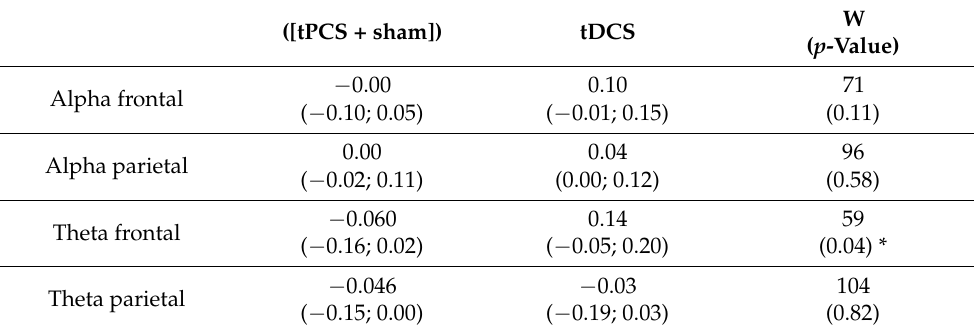
Figure 4. Group differences between treatment conditions on ([tPCS + sham]) and tDCS: ( a ) on theta frontal functional connectivity, ( b ) on CRS-R total score, and ( c ) on CRS-R modified index. Calculated with unpaired Wilcoxon signed-rank test. tPCS = transcranial pulsed current stimulation, sham = sham, tDCS = transcranial direct current stimulation. Table 3. Detailed results from the exploratory analysis testing [tPCS + sham] against tDCS condition. Cells report the median and (IQR25—IQR75) of each band and region for each condition. For example, the alpha frontal median for the [tPCS + sham] condition was − 0.002 and IQR25 − 0.107, IQR75 0.051. The last column reports the Wilcoxon index and p -value (between parentheses) for the Wilcoxon signed-rank statistical tests. tPCS = transcranial pulsed current stimulation, sham = sham, tDCS = transcranial direct current stimulation. The * indicates significance of p